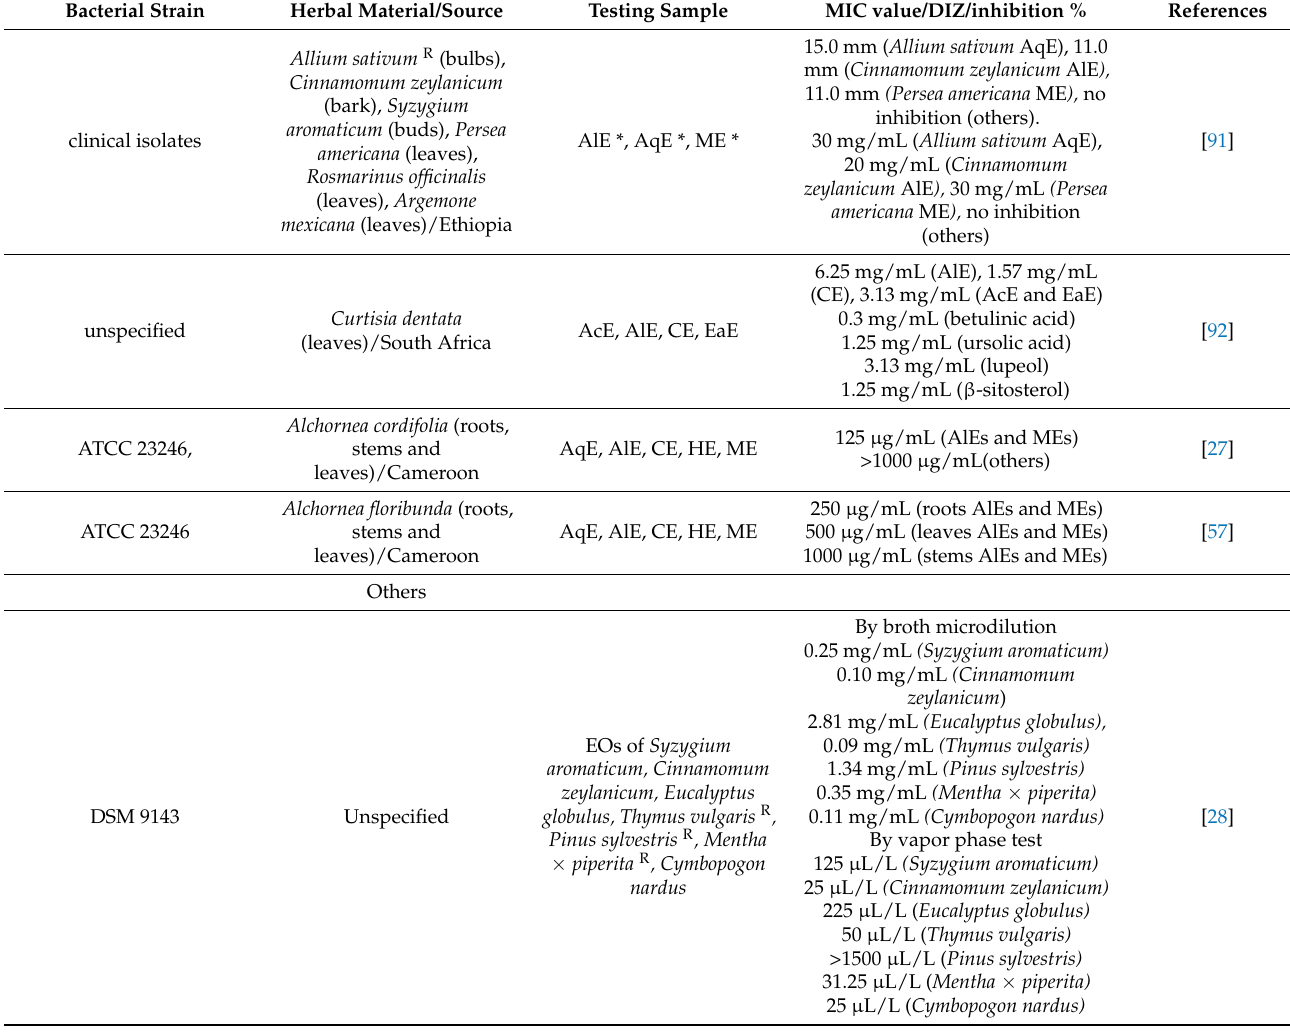
Abbreviations in Table 5: AcE = acetone extract; AqE = aqueous extract; AqF = aqueous fraction; AlE = alcoholic extract; CE = chloroform extract; CF = chloroform fraction; DcmE = dichloromethane extract; DeeE = diethyl ether fraction; EaE = ethyl acetate extract; HF= hexane fraction; HE = hexane extract; ME= methanolic extract. All extracts are dry extracts, except those marked with “*” in table. EO = essential oil. “ R ” = species identified in